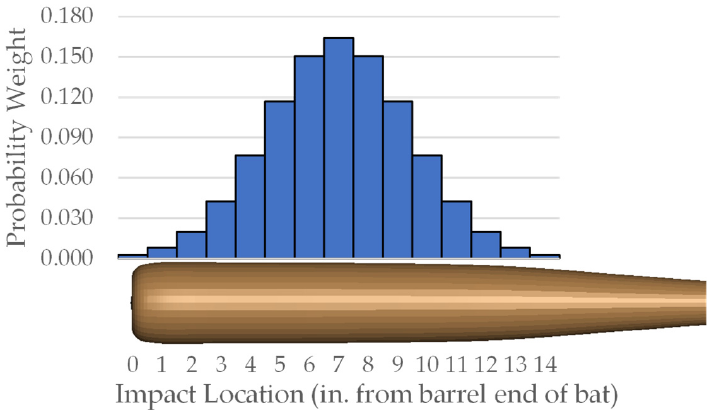
Figure 6. Probability distribution of ball impact location relative to bat position.